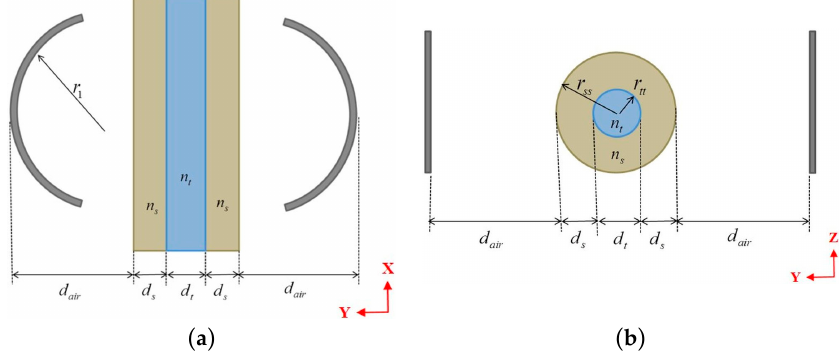
Figure 2. Schematic diagram of the cylindrical Fabry-Pérot cavity with the micro-tube inside.